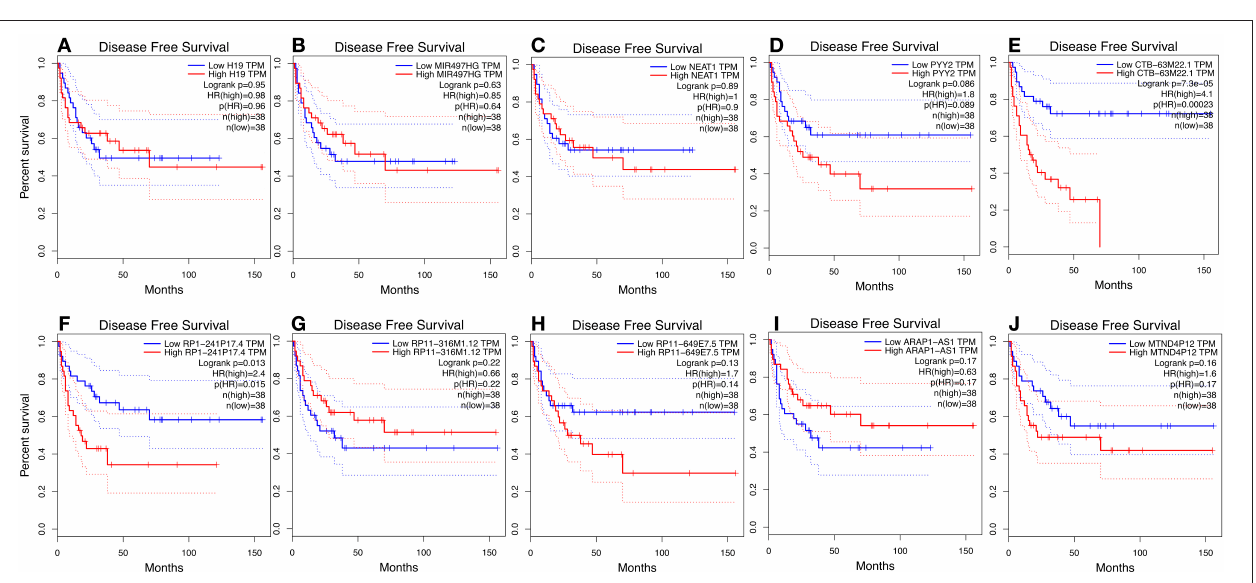
terms were classified into three groups. The ceRNA